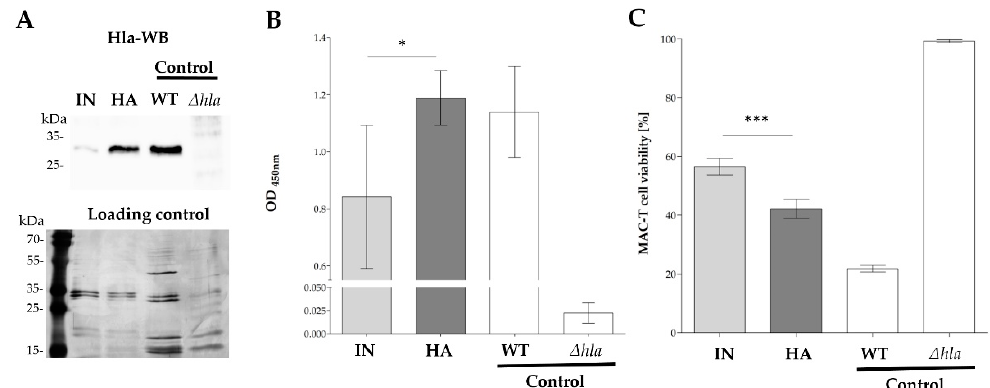
Figure 4. Hla detection, hemolysis and cellular cytotoxicity. ( A ) Western blot of alpha-hemolysin. IN and HA isolates were cultivated 24 h in RPMI, supernatants were collected, concentrated and analysed for their Hla content. A silver-stained SDS-gel was used as a loading control to ensure equal protein quantities per lane. Data are representatives of three independent experiments. ( B ) Hemolytic activity was determined using absorbance at 450 nm (released haemoglobin from sheep red blood cells after incubation with undiluted supernatant for 60 min at 37 °C). The bars represent the mean and 95% CI of three independent biological replicates and two technical replicates. ( C ) Cytotoxic effect of bacterial culture supernatant on a bovine mammary epithelial cell line (MAC-T cells). Cells were incubated with undiluted bacterial supernatants for 24 h to analyse the cell viability. Measurements were normalised to the cytotoxicity of MAC-T cells treated with RPMI + DFOM medium. Experiments were performed in three independent biological replicates, each with three technical replicates +/ − 95% CI. ( A – C ) (* p < 0.05; *** p < 0.001). IN, initial isolate; HA, host-adapted isolate. Assay control strains: WT, Strain 6850; Δ hla , Strain 6850 Δ hla .